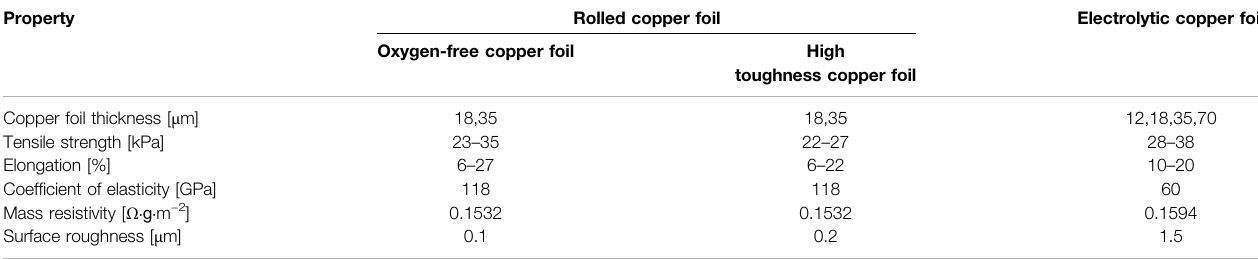
TABLE 1 | Main properties of copper foil. Property Rolled copper foil Electrolytic copper foil Oxygen-free copper